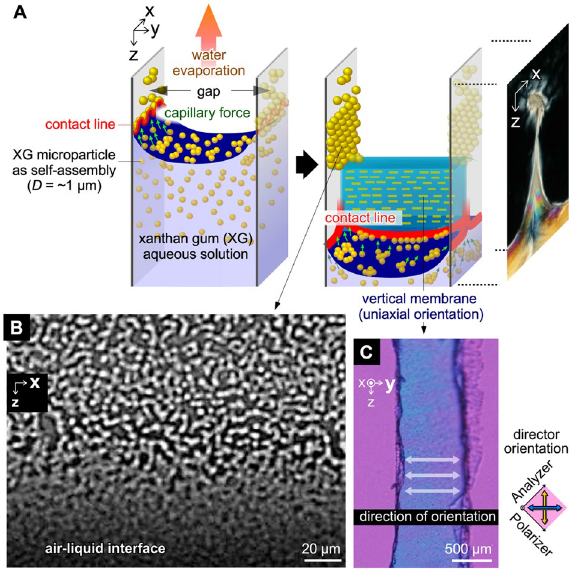
Figure 1. Deposition of polysaccharide microparticles from evaporative air–LC interface. ( A ) Schematic of microparticle depositions on evaporative air–LC interface and vertical membrane formation. ( B ) Optical microscopic images of XG deposited on a substrate. Initial concentration of XG: 0.5 wt%. Drying at 60 °C. ( C ) Microscopic image of dried vertical membrane through crossed Nicols with a first-order retardation plate (λ = 530 nm). Inner dimensions of the cell: (X-width, Y-thickness, Z-depth) = (15 mm, 1 mm, ~ 20